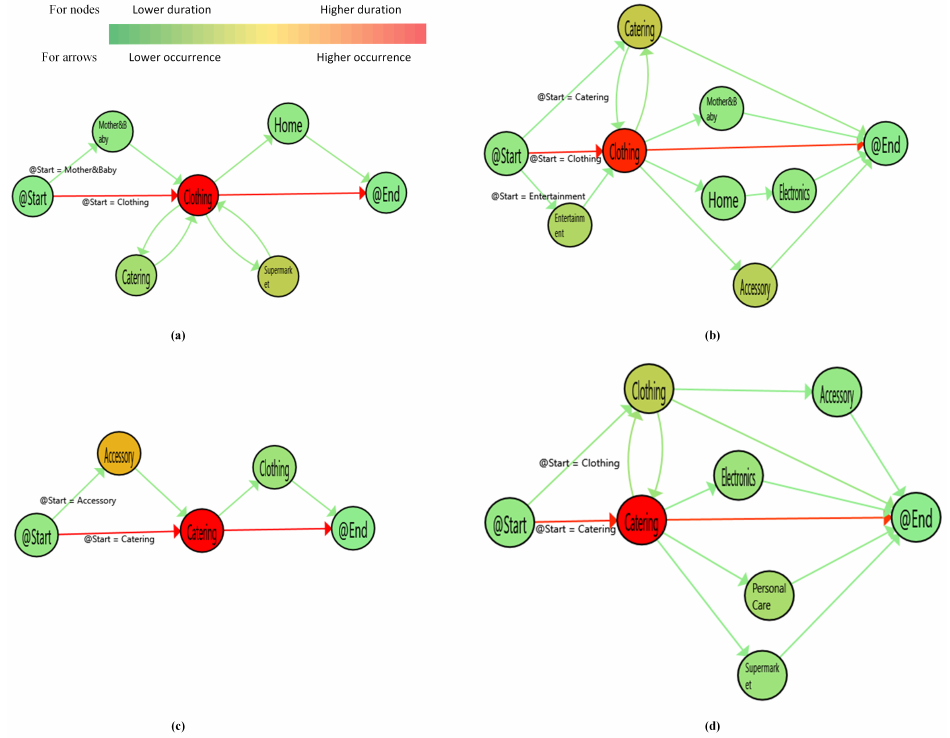
Figure 5. Customers’ paths in December. ( a ): Male paths-1st cluster ( b ): Female paths-1st cluster ( c ): Male paths-2nd cluster ( d ): Female paths-2nd cluster.